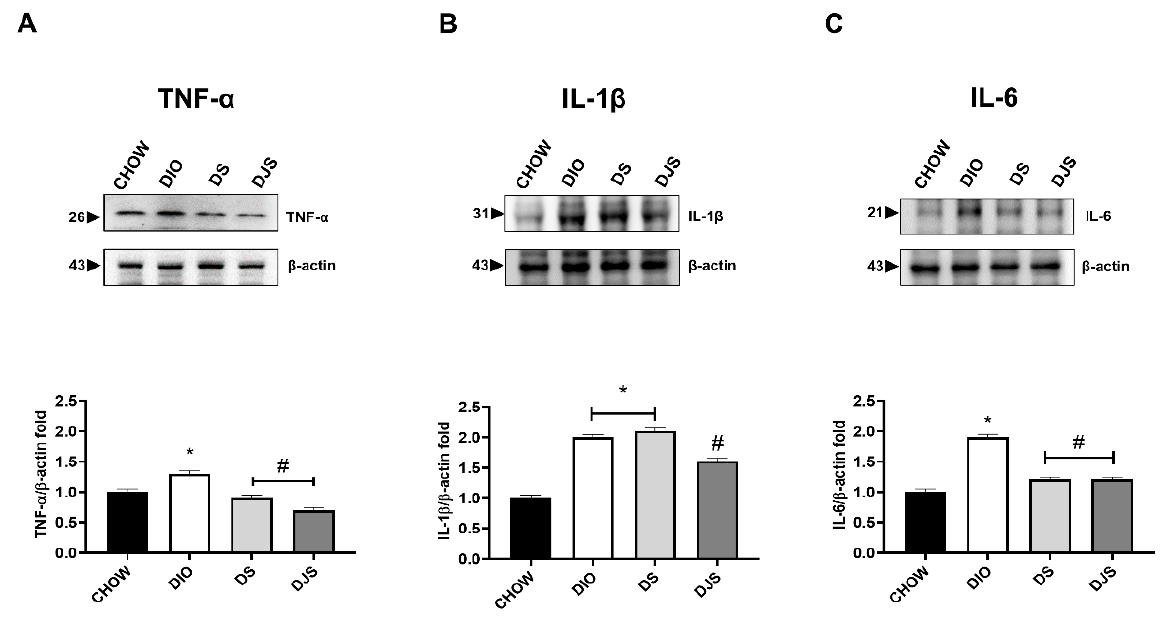
Figure 7. Western blot analysis of inflammatory cytokines. Cardiac lysates were immunoblotted using antibodies against tumor necrosis factor- α (TNF- α ) ( A ), anti-interleukin-1 β (IL-1 β ) ( B ), and interleukin-6 (IL-6) ( C ). Graphs show the densitometric ratios of bands and β -actin expression used to normalize the data. CHOW rats ( n = 8), reference group fed with standard diet; DIO rats ( n = 9), fed with high-fat diet; DS ( n = 12), DIO rats supplemented with tart cherry seeds; DJS ( n = 9), DS rats supplemented with tart cherry juice. Data are mean ± SEM. * p < 0.05 vs. CHOW rats; # p < 0.05 vs. DIO rats.